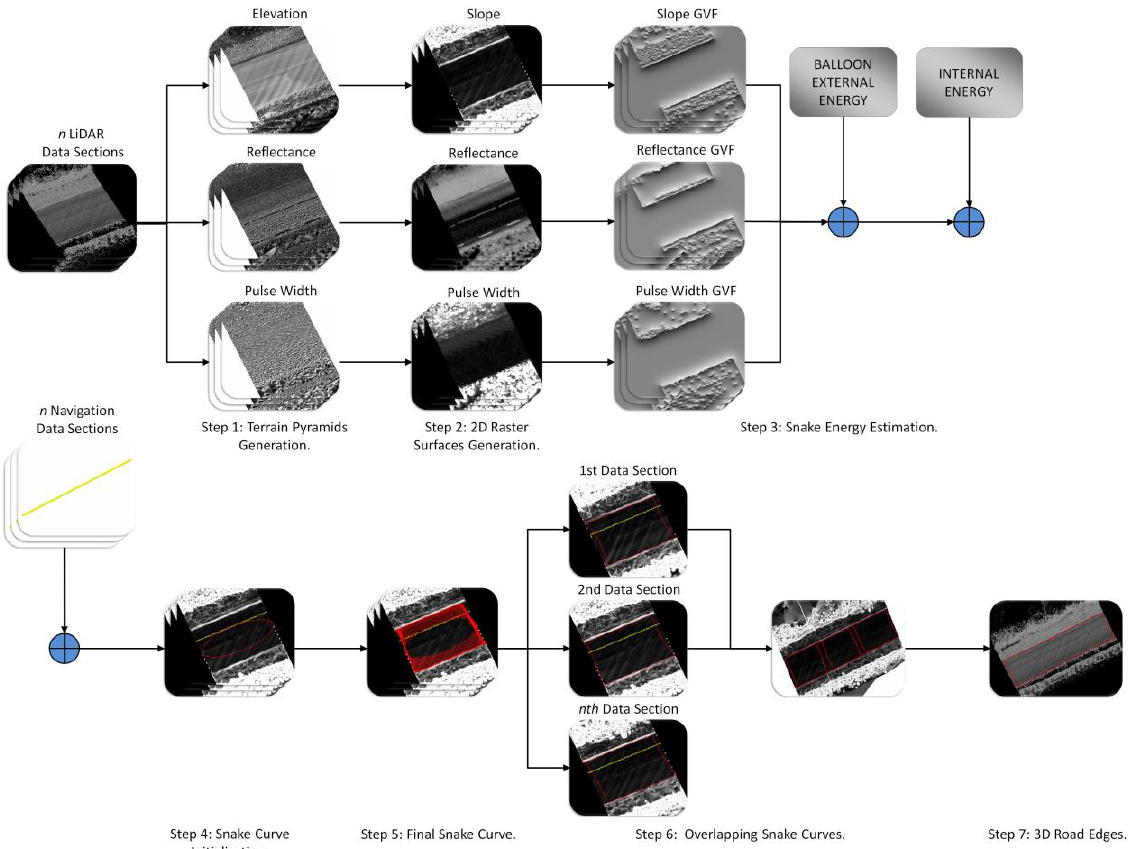
Figure 1: Road edge extraction algorithm (Kumar et al.,